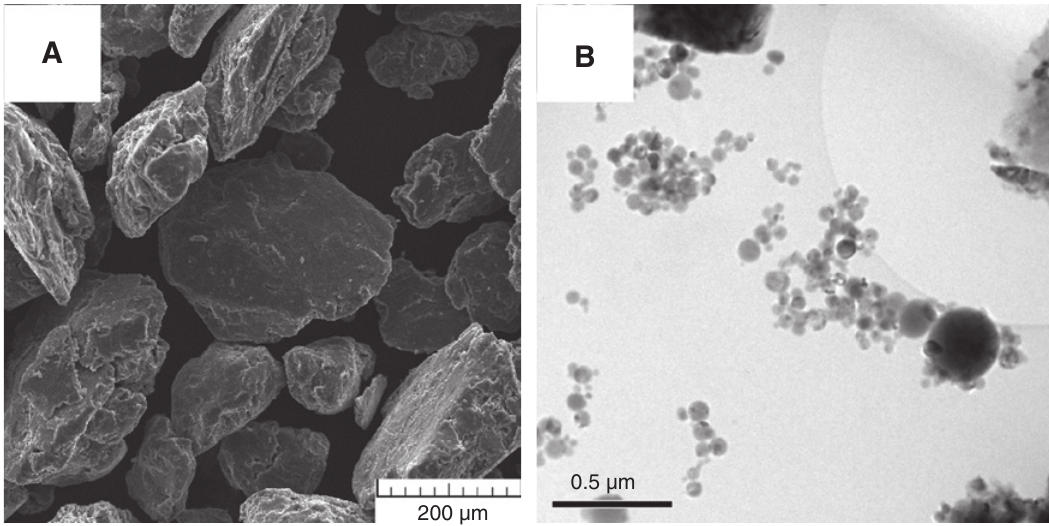
Figure 2: Input powders: (A) Mg particles (50–250 μ m), (B) HA particles (TEM).